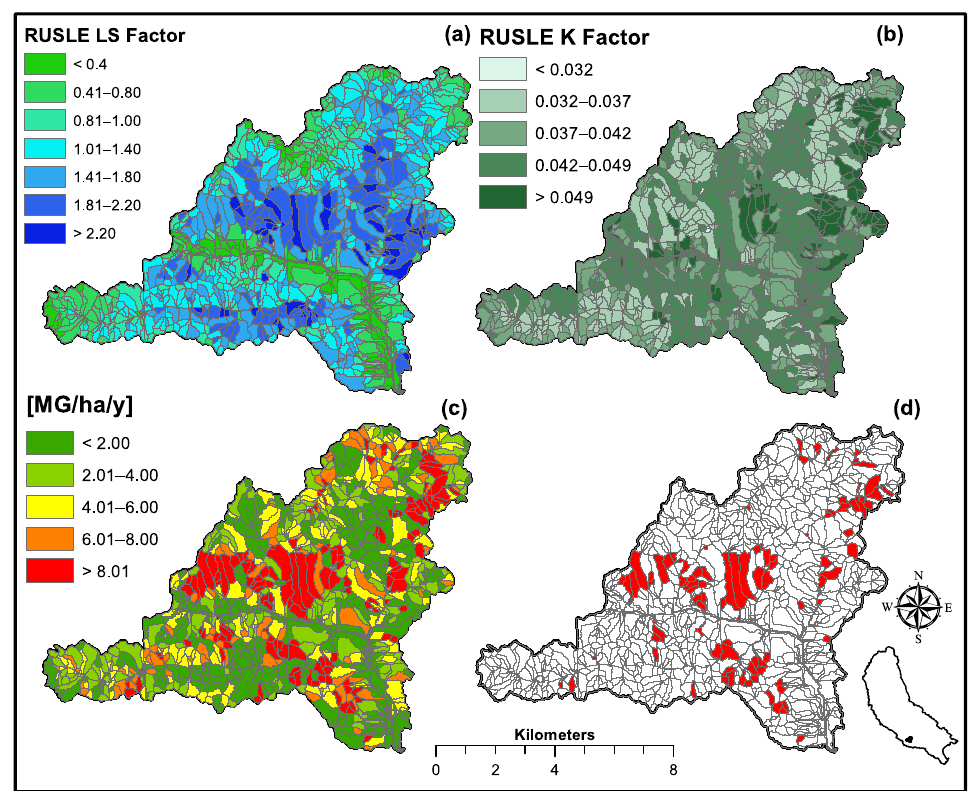
Figure 10. Illustration of information generated at the sub-catchment level (field) which can be used to support natural resources conservation efforts locally at sub-watershed level and regionally. It is illustrated with the RUSLE LS factor ( a ), RUSLE K factor ( b ), annual average per unit of area clay size yield ( c ), and top 100 most producing sub-catchments ( d ).